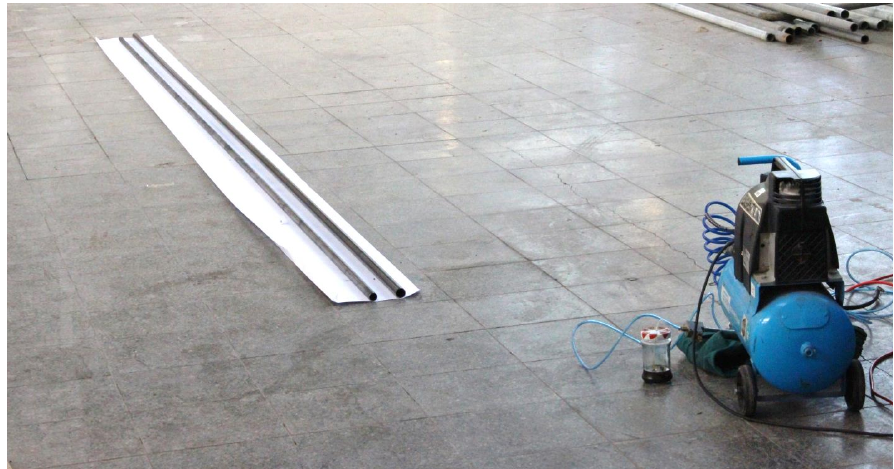
Figure 1. Application environment for experimental coating of inner surface of tubes by dispersion oil fraction and